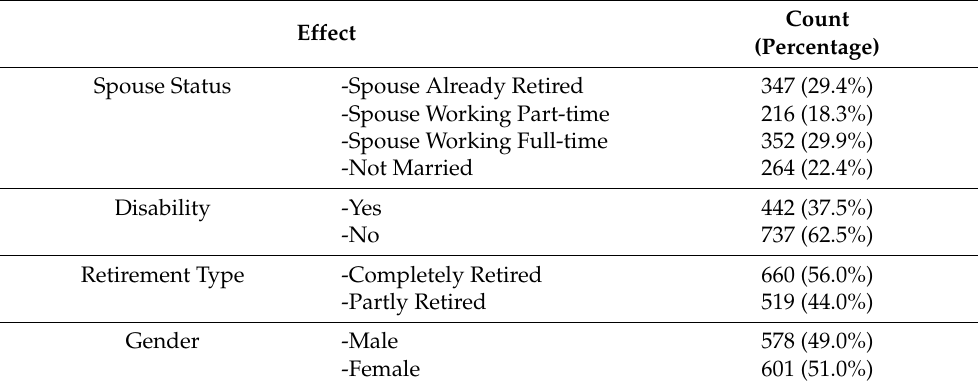
Table 1. Frequencies and percentages per variable ( n =